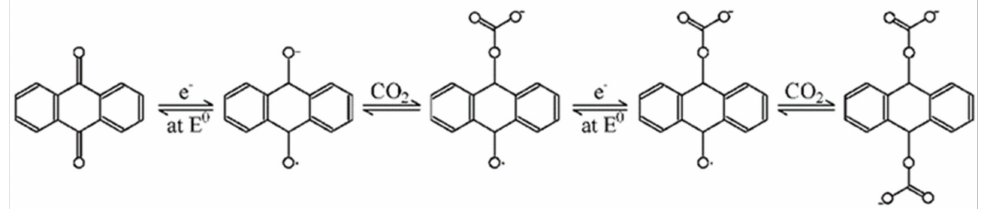
Figure 6. TEM of MWCNTs ( a , c ) and TEM of PAQ/MWCNTs composites ( b , d ). This figure was created by the author.